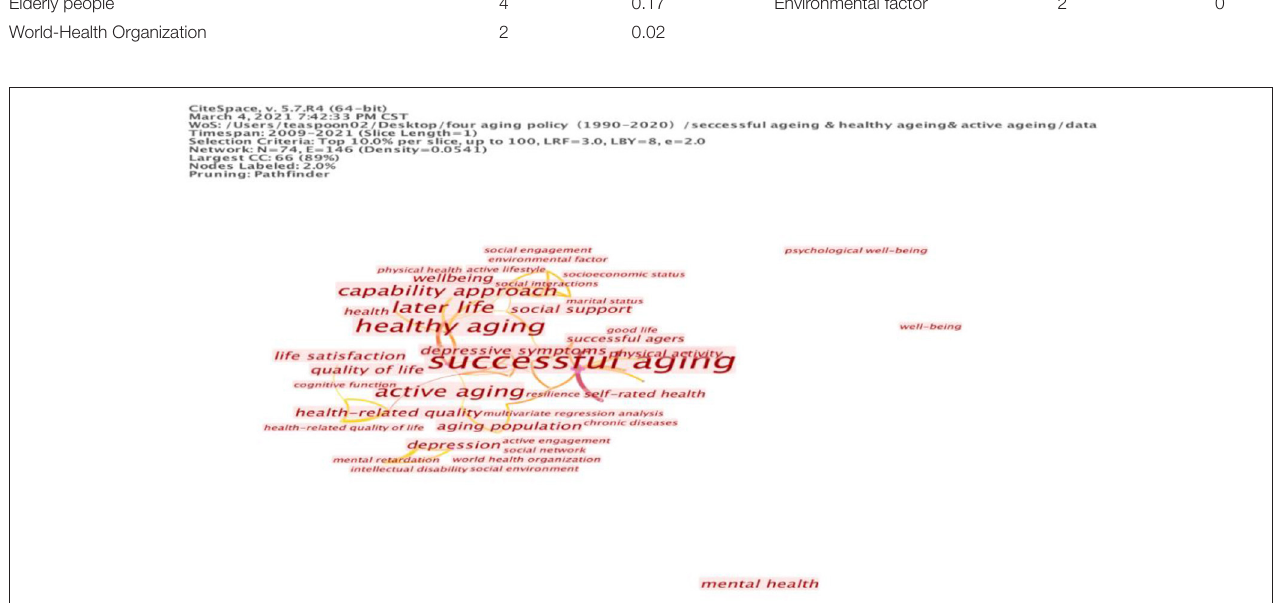
FIGURE 5 | Cluster map of keywords on successful aging AND healthy aging AND active